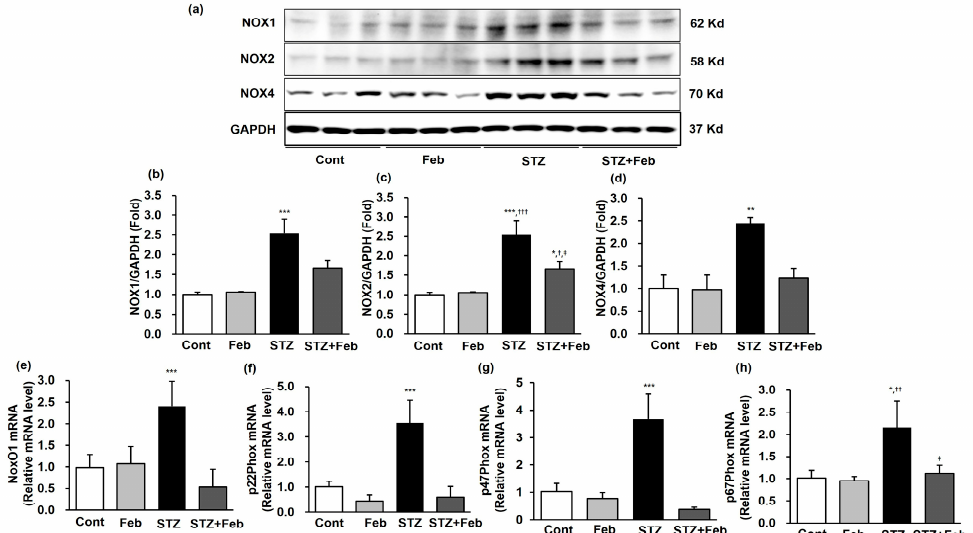
Figure 4. Representative images and quantitative analysis of NADPH oxidase and the mRNA expression of NADPH oxidase subunits in STZ-induced diabetic mice with or without febuxostat treatment. ( a ) Representative immunoblots of NOX1, NOX2 and NOX4 expressions. ( b ) Quantitative analyses for NOX1/GAPDH, *** p < 0.001 vs. other groups. ( c ) Quantitative analyses for NOX2/GAPDH, * p < 0.05 and *** p < 0.001 vs. Cont, † p < 0.05 and ††† p < 0.001 vs. Feb and ‡ p < 0.05 vs. STZ group. ( d ) Quantitative analyses for NOX4/GAPDH, ** p < 0.01 vs. other groups. ( e ) NoxO1 mRNA, *** p < 0.001 vs. other groups. ( f ) p22phox mRNA, *** p < 0.001 vs. other groups. ( g ) p47phox mRNA, *** p < 0.001 vs. other groups. ( h ) p67phox mRNA, * p < 0.05 vs. Cont, †† p < 0.01 vs. Feb and ‡ p < 0.05 vs. STZ group.